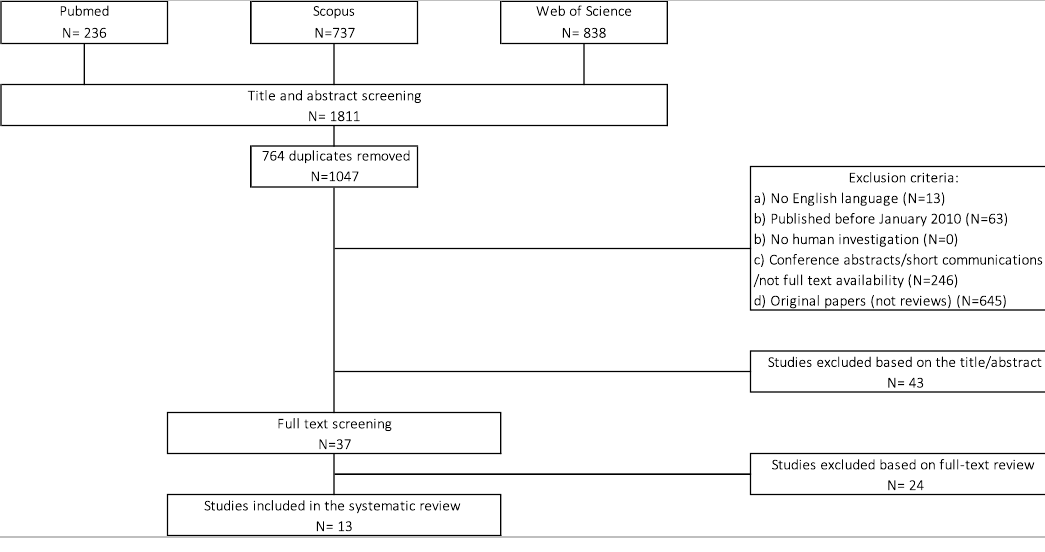
Figure 2. PRISMA (Preferred Reporting Items for Systematic Reviews and Meta-Analyses) flowchart for Parkinson’s disease (PD) reviews. for Parkinson’s disease (PD)